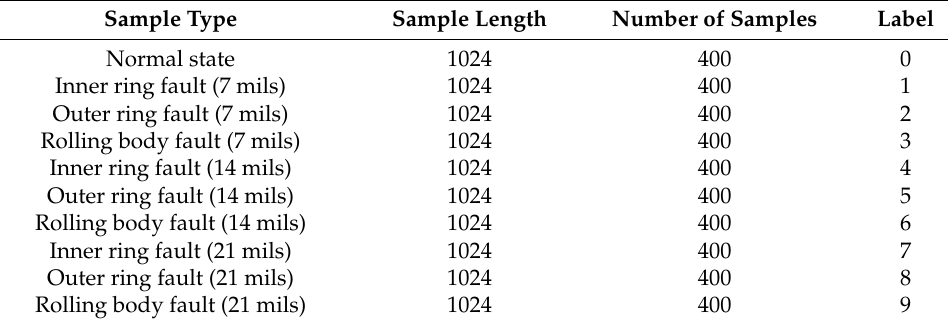
Table 1. Composition of experimental samples.